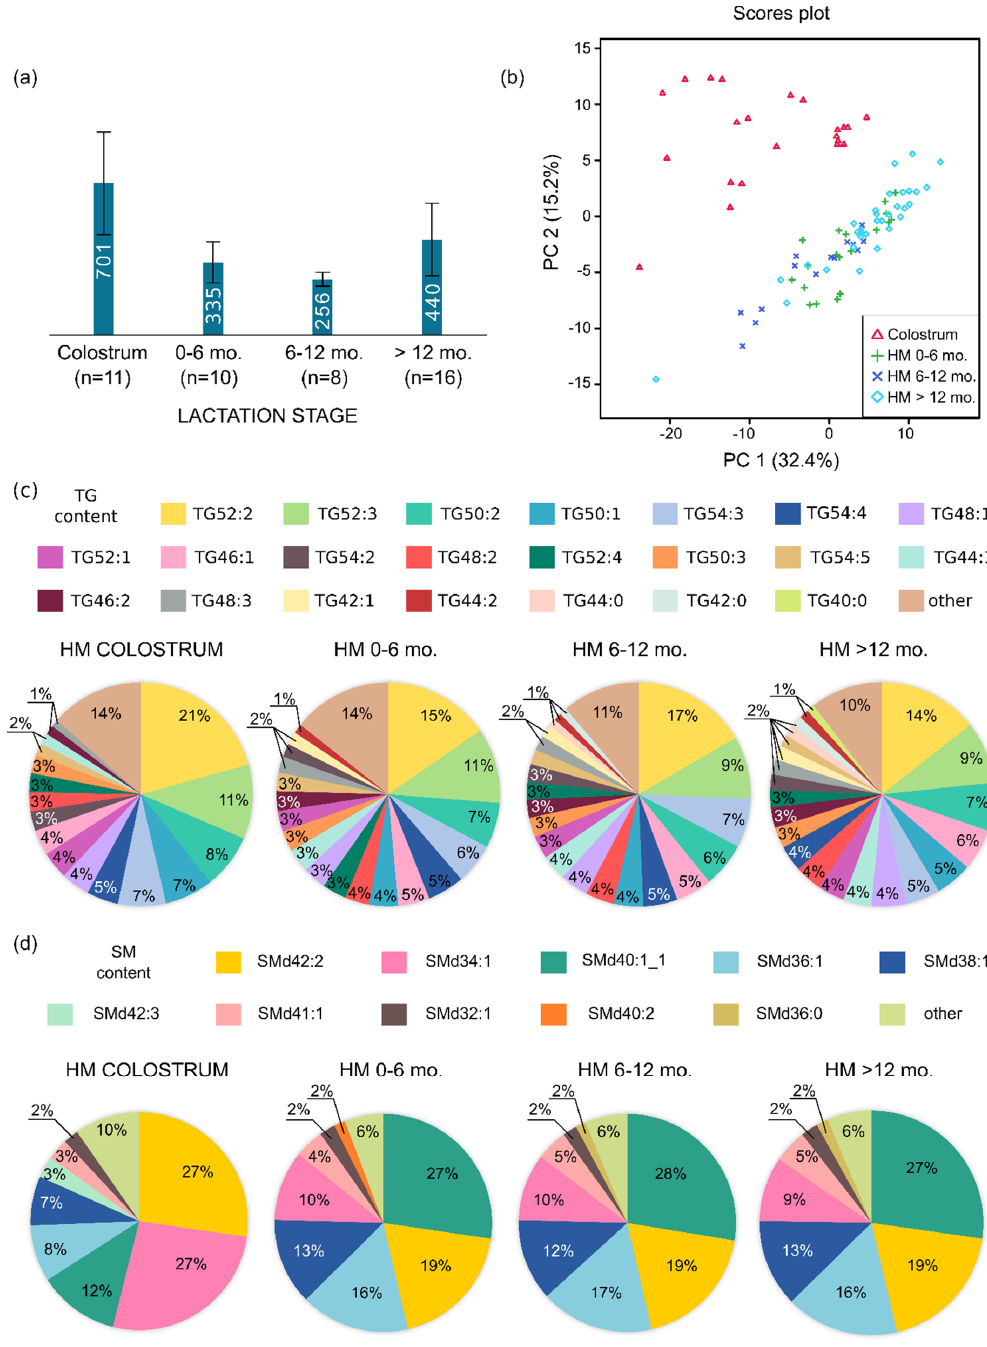
Figure 1. ( a ) Average number of MFs detected in HM samples collected in different lactation stages. ( b ) PCA score plot of the lipid fingerprints of HM samples: colostrum (red triangles); HM 0–6 months (green plus sign); HM 6–12 months (dark blue cross); HM >12 months (light blue diamonds). ( c ) Average percentage relative amount of lipid species in HM samples within the TG class. ( d ) Average percentage relative amount of lipid species in HM samples within the SM class. MF, molecular feature; SM, sphingomyelin; TG, triacylglycerol.